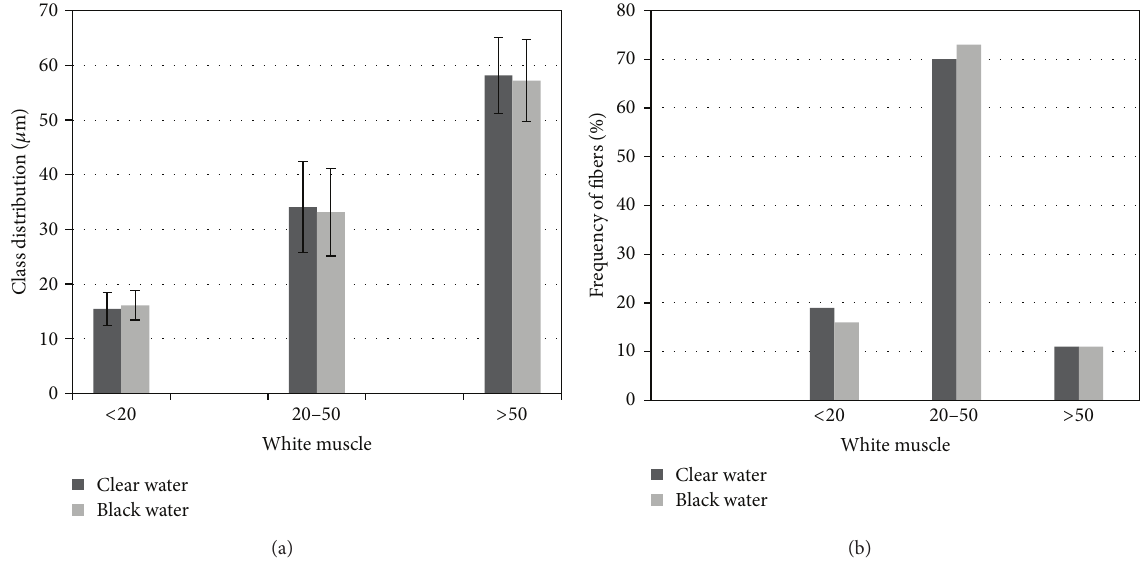
Figure1:Distribution(a)andfrequency(b)ofwhitemusclefibersof Colossomamacropomum fromclearandblackAmazonwaters,according to the diameter class